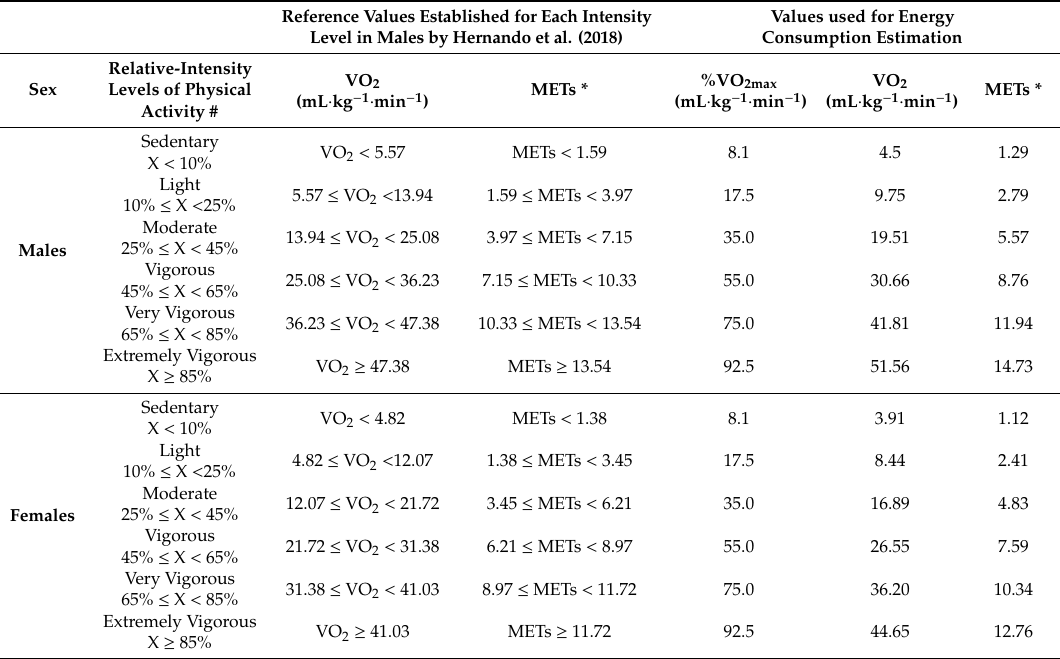
Table 1. Values established for delineating the six-relative intensity levels of physical activity according to runner’s